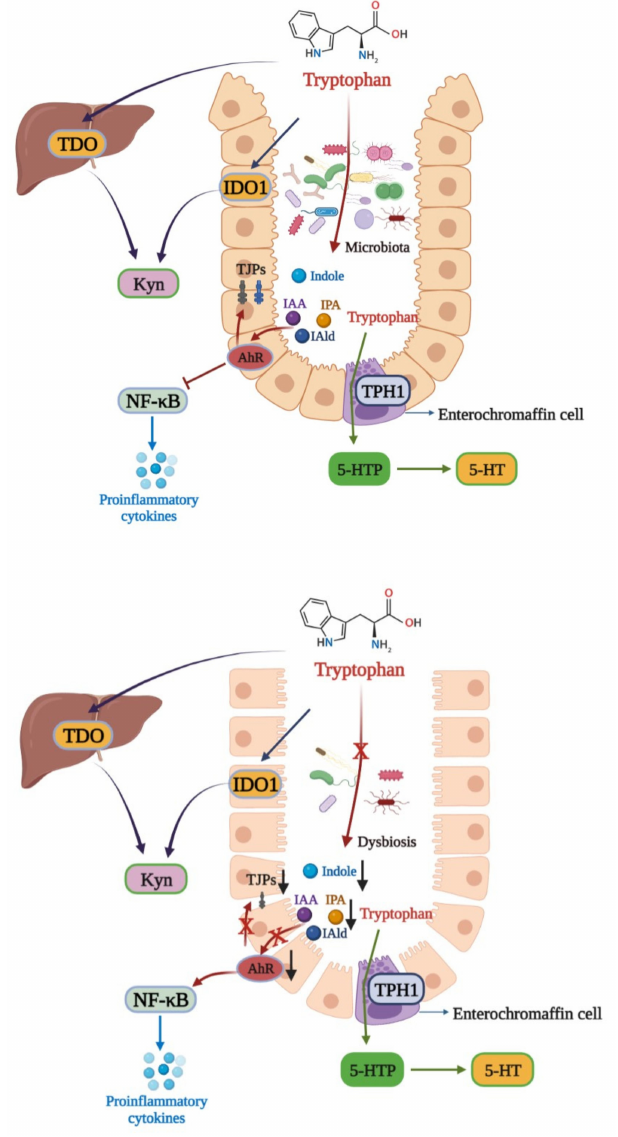
Figure 2. Tryptophan metabolism disturbance in IBD. There are three main metabolic pathways of tryptophan. The major pathway is the Kyn pathway, with tryptophan also being metabolized into indole derivatives. In healthy individuals, the gut microbiota metabolize tryptophan into IAA, IPA, and IAld, which can activate AhR to exert a protective effect in the colon via inhibiting NF- κ B and increasing TJPs expressions. In IBD, gut microbiota dysbiosis leads to the microbial activation of tryptophan, aggravating intestinal inflammation. TPH1: tryptophan hydroxylase 1; 5-HTtp: